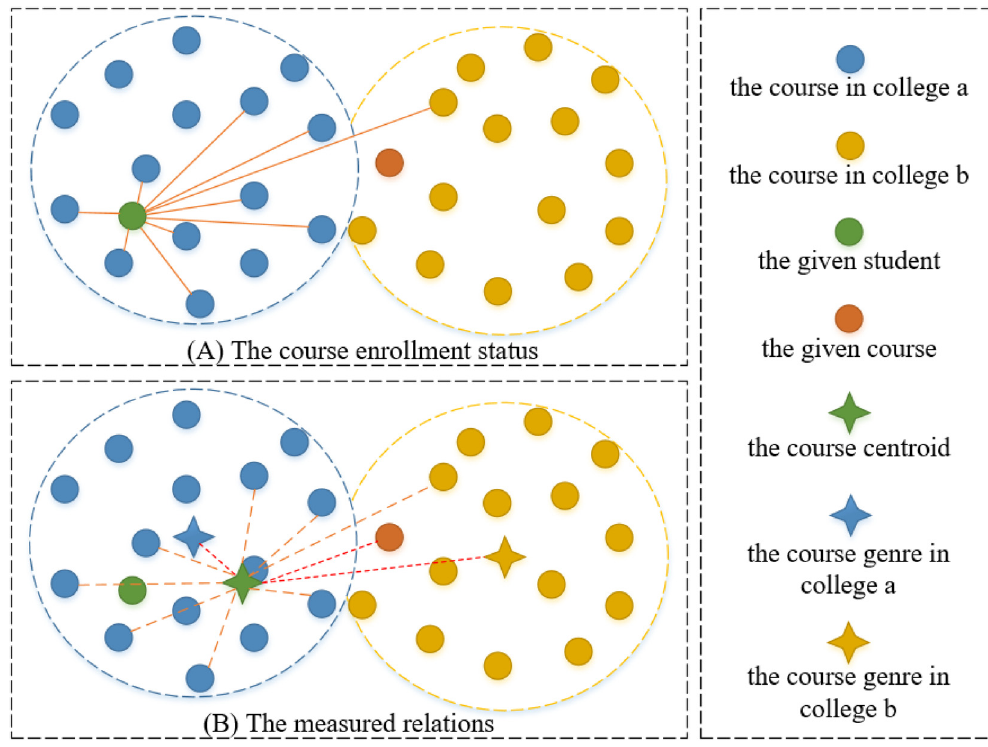
Fig 5. Illustration of the graph-based features. (A) The course enrollment status. (B) The measuredrelations.